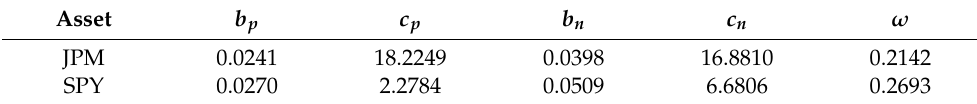
Table 1. Marginal BG parameters for the 29 day maturity on 12 December 2019.